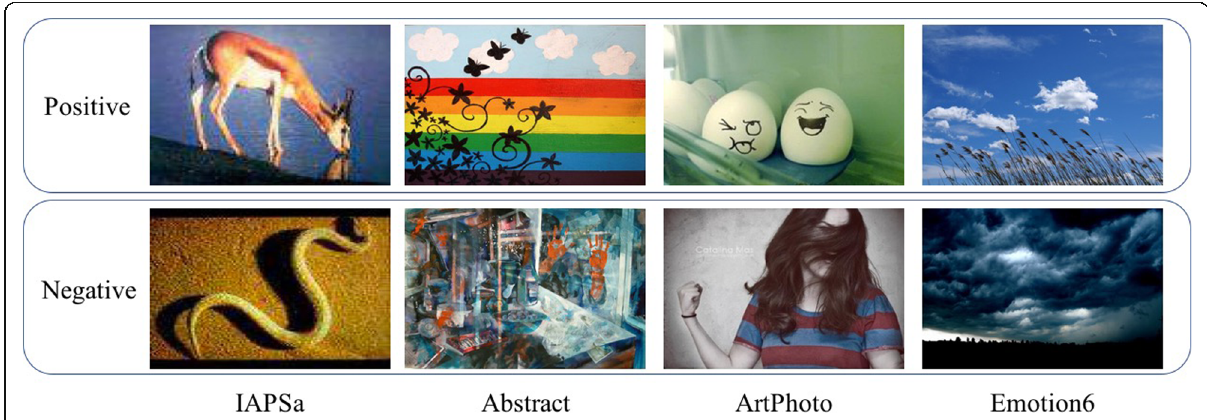
Fig. 3 Positive and negative image examples from data